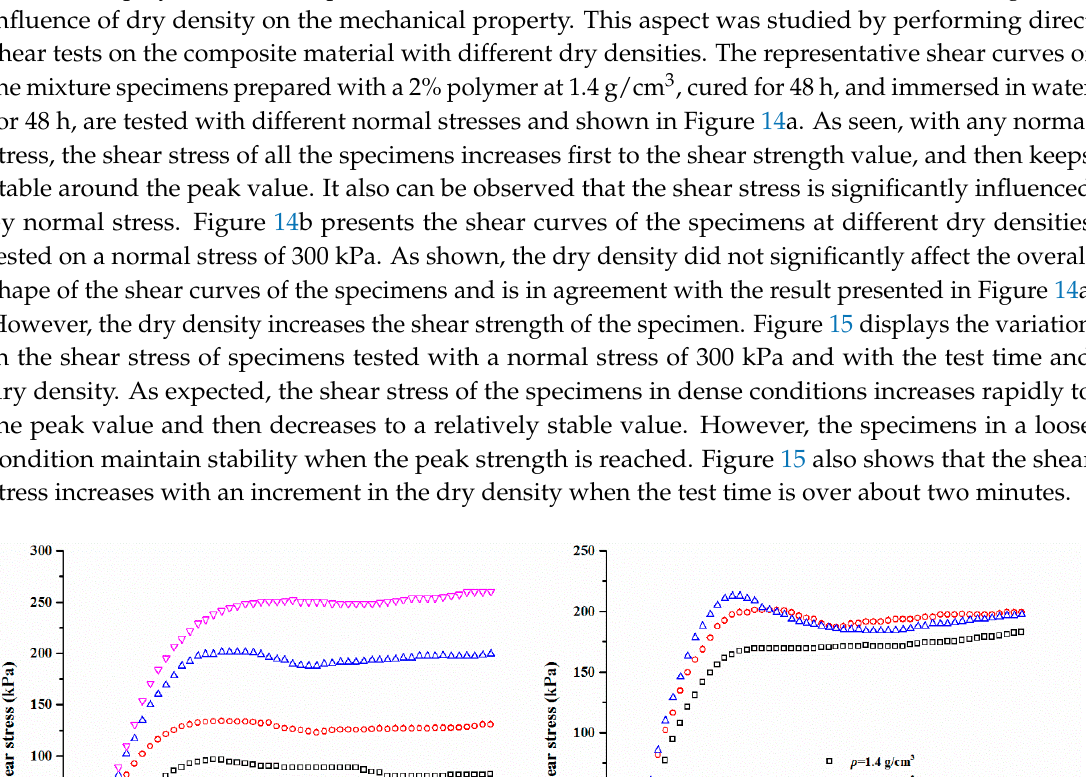
Figure 13. ( a ) The linear relationship between the shear stress τ and normal stress σ ; ( b ) The relationship between the shear strength parameters ( c and φ ) and the polymer content W r .